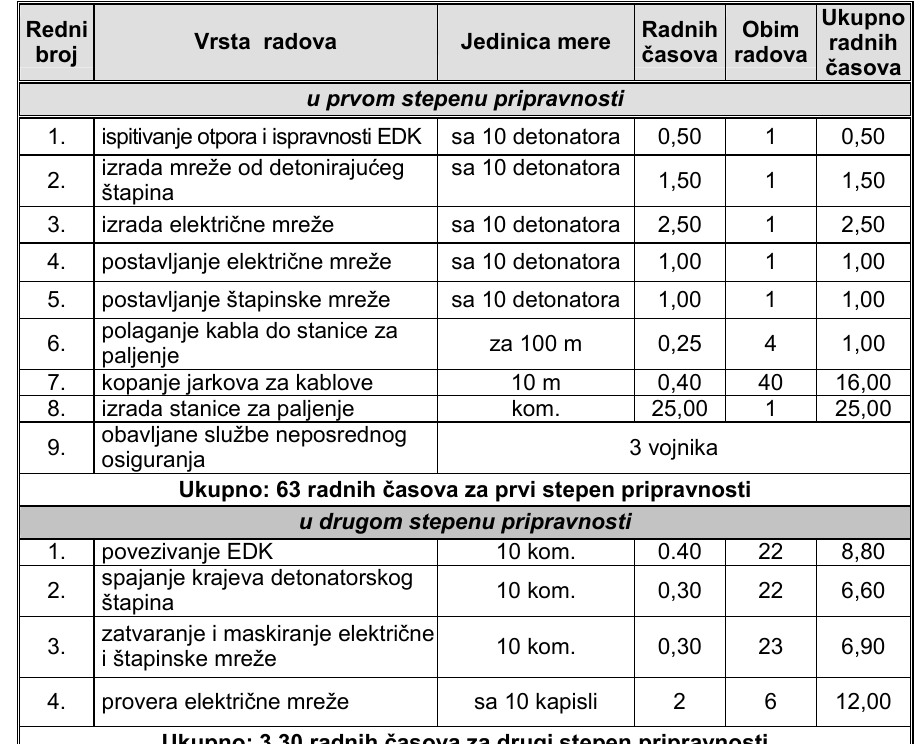
Tabela 2 – Prora č un ostalih radova Таблица 2 – Расчет других